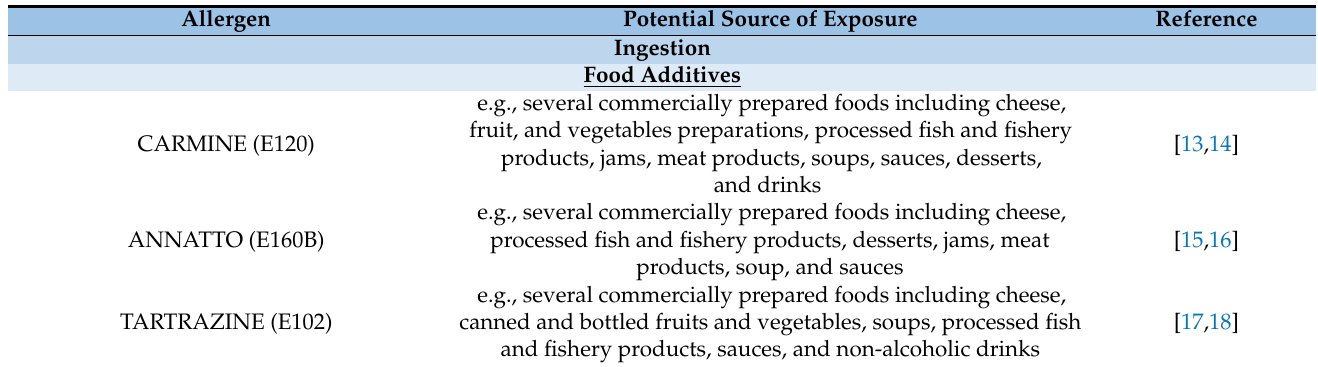
Table 1. Potential sources of rare and hidden